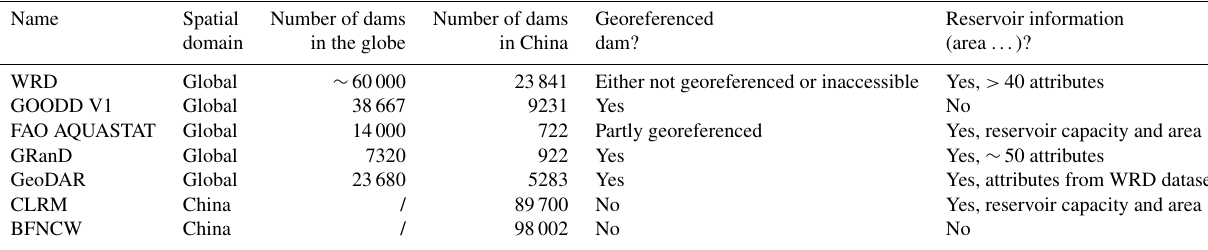
Table 1. Information on published dam and reservoir datasets for the globe and China.